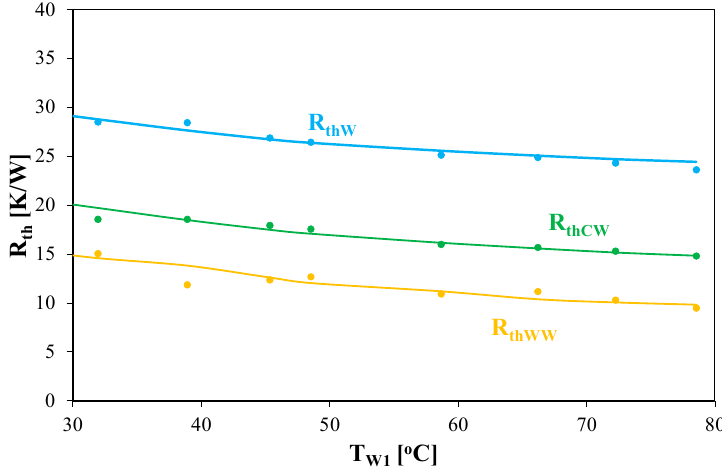
Figure 11. Dependence of thermal resistances of the inductor components on the temperature of the winding in which the power is dissipated.